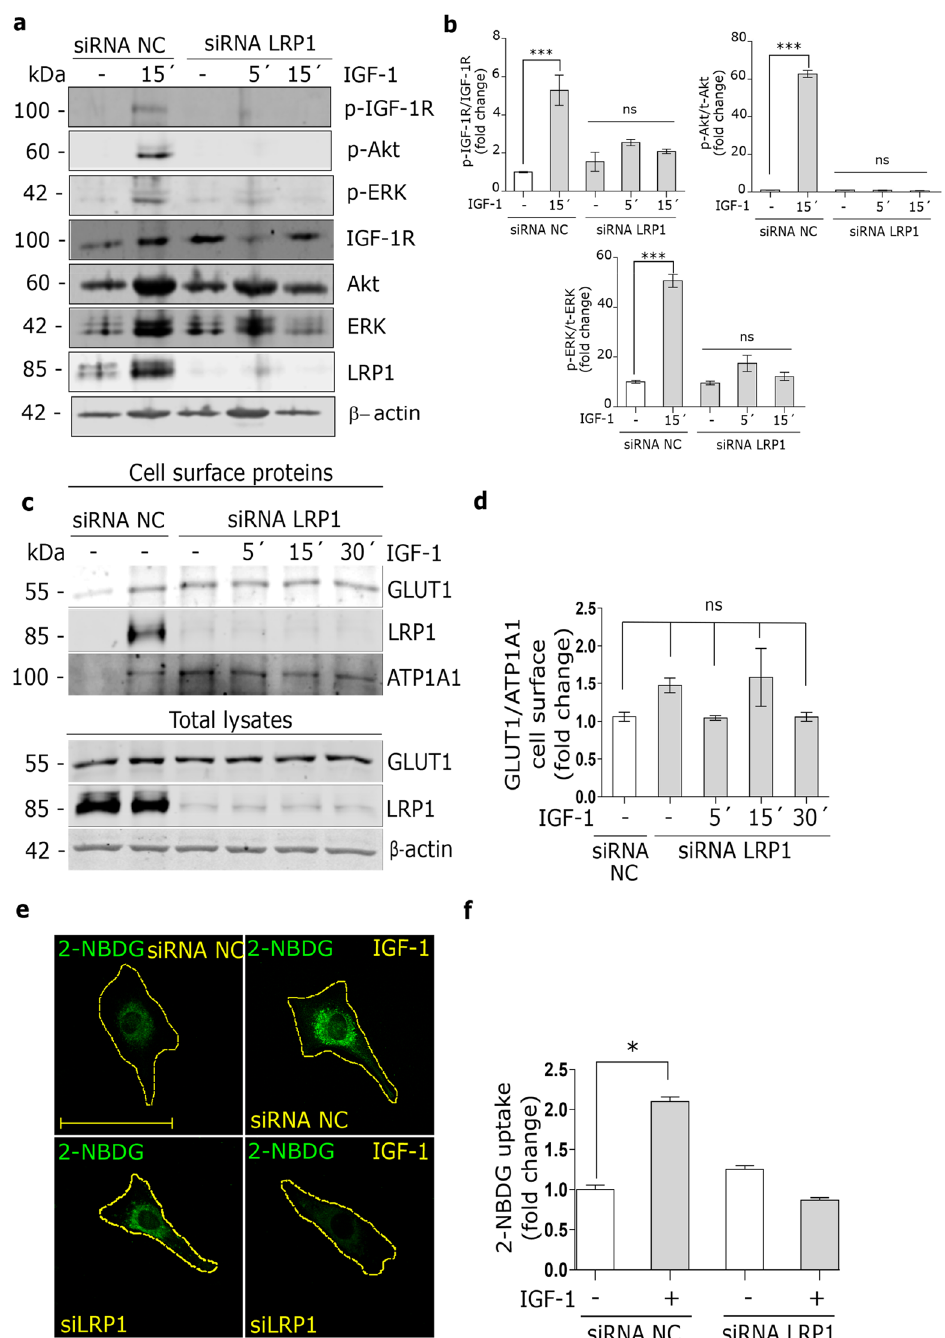
Figure 5. IGF-1-induced GLUT1 traffic to PM and glucose uptake are dependent on LRP1 expression. ( a ) Western blot assay for the analysis of phosphorylated IGF-1R (p-IGF-1R; T1316), Akt (p-Akt; T308) and ERK 1/2 (p- ERK1/2; Thr202/Tyr204) in MIO-M1 cells treated or not with siRNA for LRP1 and then stimulated with IGF-1 10 nM for 5–15 min. Total IGF-1R, Akt, ERK1/2 and β-actin were used as loading control. ( b ) Densitometric quantification of Western blot data expressed as fold change respect to non-stimulated control (white bar). Values are expressed as mean ± SEM. *** p < 0.001 versus non-stimulated control. ns = non-significant differences. Three independent experiments in duplicate were performed (n = 6). ( c ) Biotin-labeling protein assay to measure expression of GLUT1 and LRP1 in the PM of MIO-M1 cells treated or not with siRNA for LRP1 and then stimulated with IGF-1 10 nM for 5–30 min. Biotin-labeled proteins were isolated with streptavidin-conjugated beads and then analyzed by Western blot. ATP1A1 and β-actin were used as protein loading controls. Line 1: control without biotin. ( d ) Densitometric quantification of Western blot data for surface GLUT1 related to ATP1A1 expressed as fold change respect to non-stimulated control (white bar). Values are expressed as mean ± SEM. ns = non-significant differences. Three independent experiments in duplicate were performed (n = 6). ( e ) Confocal microscopy in MIO-M1 cells treated with specific siRNA for LRP1 (siLRP1) and then stimulated with IGF-1 10 nM together with 2-NBDG 80 µM (green) for 30 min. Dotted line represents the cell shape. Images are representative of 20 cells per condition (n = 20). Scale bar = 10 μM. ( f ) Graph represents mean ± SEM of the fluorescence intensity of 2-NBDG per cell area expressed as fold change. * p < 0.05 versus non-stimulated control (white